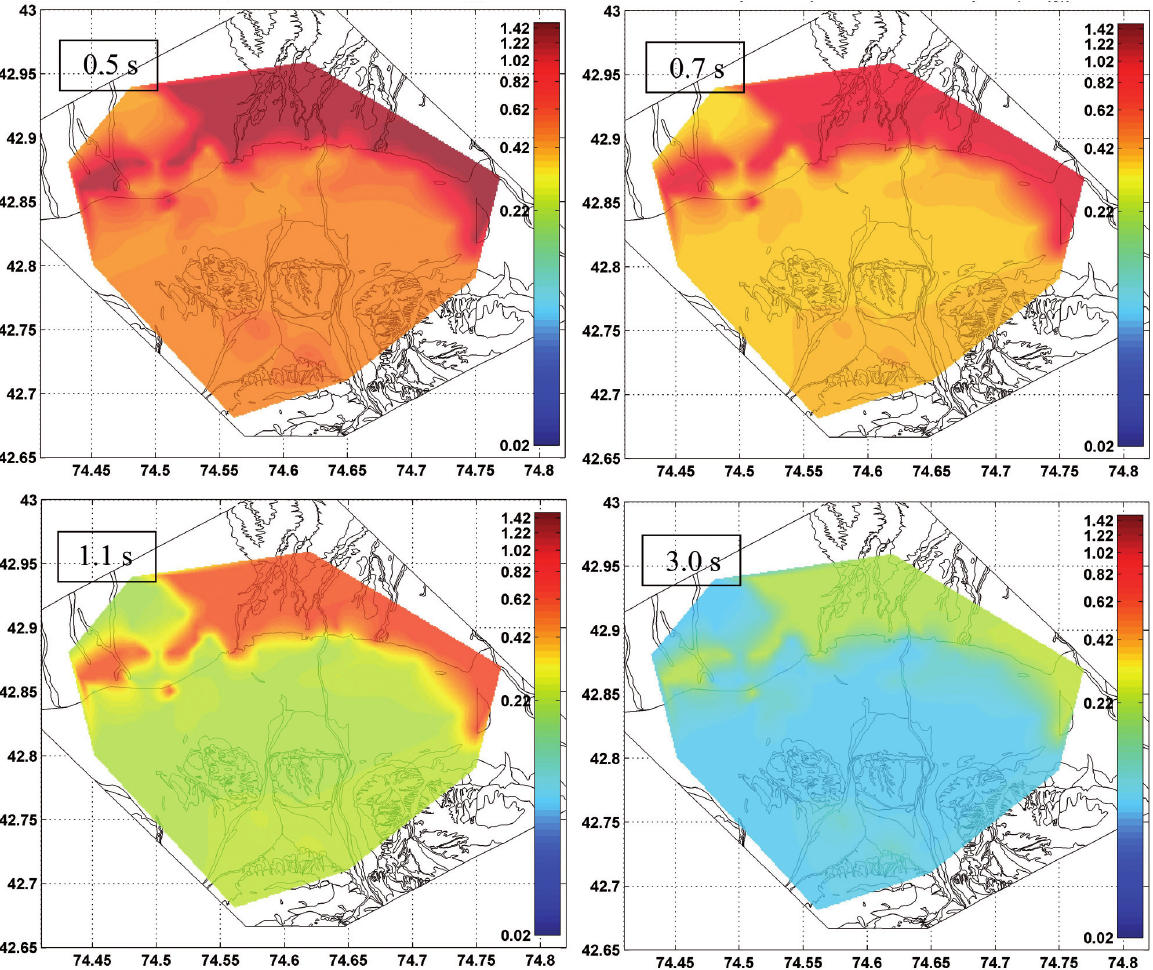
Figure 14. Estimated hazard for 10% probability of exceedance in 50 years considering site effects in terms of response spectrum ratios for different spectral